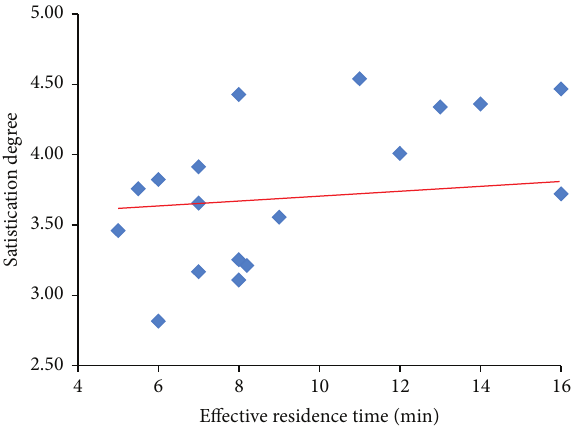
Figure 9: Effective residence time and satisfaction